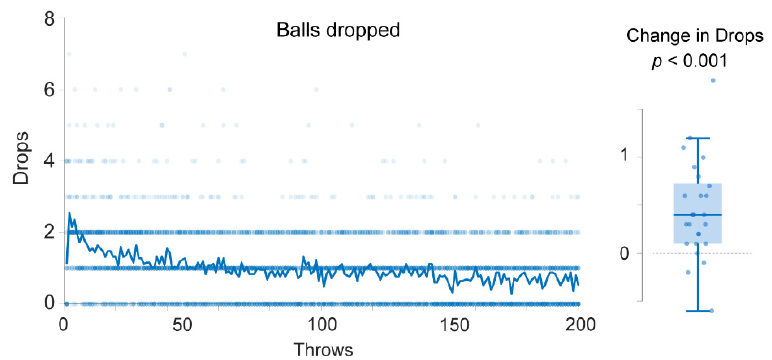
Figure 3. Drops. The figure shows the number of drops before each successful two-ball throw for all participants. Each dot represents the number of drops before one successful attempt for one participant. The line in the middle shows the median value. There is a clear decline in the number drops before each successful attempt as the participants spend more time in the simulator, suggesting that participants improved their performance over time. The boxplot to the right shows the distribution of change in drops. For each participant, the average number of drops on the last 10 trials (191–200) was subtracted from the number of drops on throws